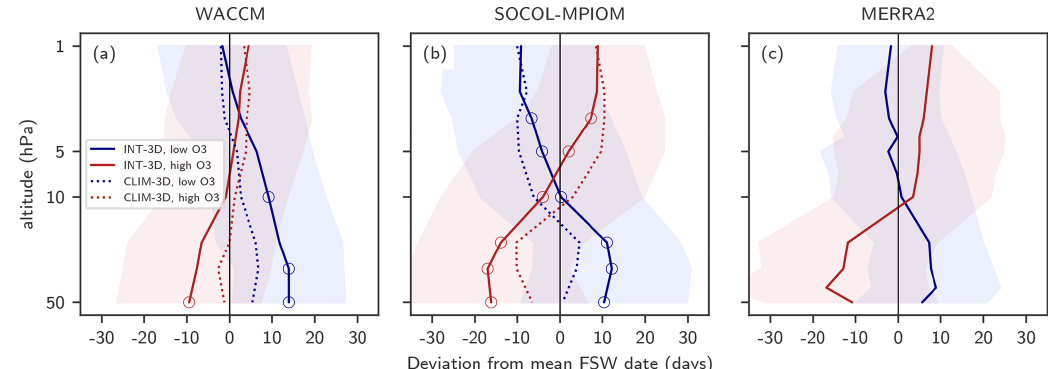
Figure 2. The impact of ozone on the FSW date at different altitudes. The mean FSW date in the years with the 25% highest ozone (red) and the years with the 25% lowest ozone (blue) at different altitudes compared to the mean FSW date in all years in (a) WACCM, (b) SOCOL- MPIOM, and (c) MERRA2. Datasets cover 200 years for WACCM and SOCOL-MPIOM and 41 years for MERRA2. Solid lines show the mean FSW dates in the INT-3D model evaluation and in MERRA2, and stippled lines show the same information in CLIM-3D. Shaded areas show the standard deviation of the FSW date in INT-3D (a, b) and in MERRA2 (c) . Circles mark altitudes where the FSW dates in high- or low-ozone springs between INT-3D and CLIM-3D differ significantly, according to a two-sided Student’s t test at the 5% level.